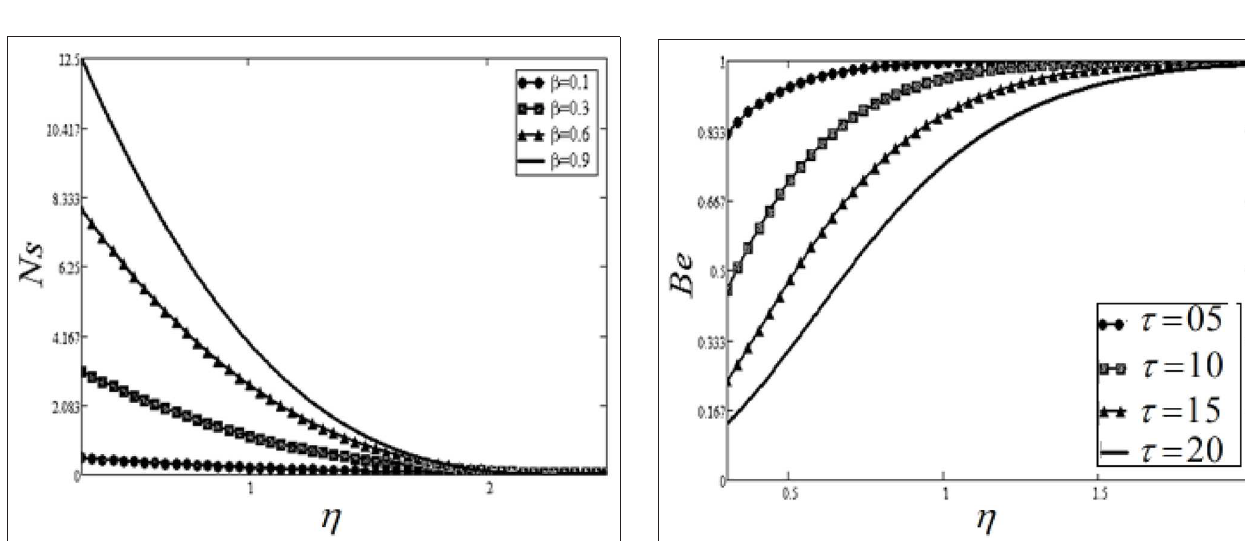
FIGURE 8 | Entropy generation plot for β .